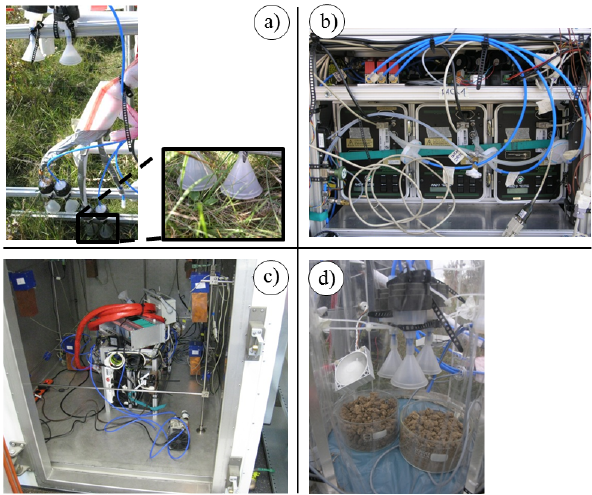
Fig. 2. Setup of the automated Tn and Rn profile system: (a) field installation of the inlets, (b) rack installation of the system in the housing, (c) setup in the thoron progeny chamber of the PTB in Braunschweig, (d) arrangement of inlets and soil samples during the side-by-side measurements in the dynamic chamber.